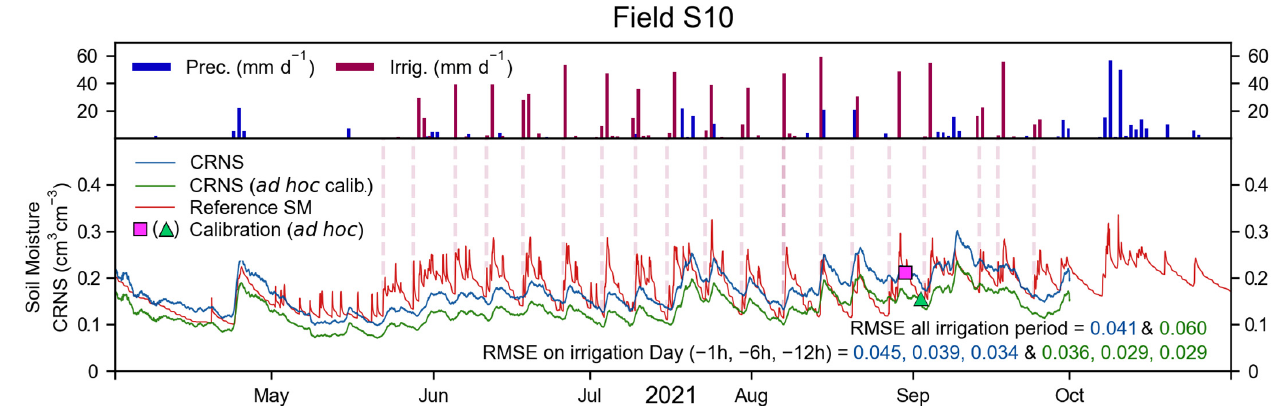
Figure 6. For field S10, during the 2021 irrigation period: precipitation, irrigation, reference SM, and CRNS-derived SM obtained with a standard calibration procedure (blue line and pink square) and with an ad hoc calibration procedure (green line and triangle). The RMSE of the entire irrigation period and at one, six, and twelve hours before irrigation is shown in the bottom panel. Irrigation dates selected for the RMSE calculation are marked with red, vertical, dashed lines. Regressions of these measurements are provided in Appendix